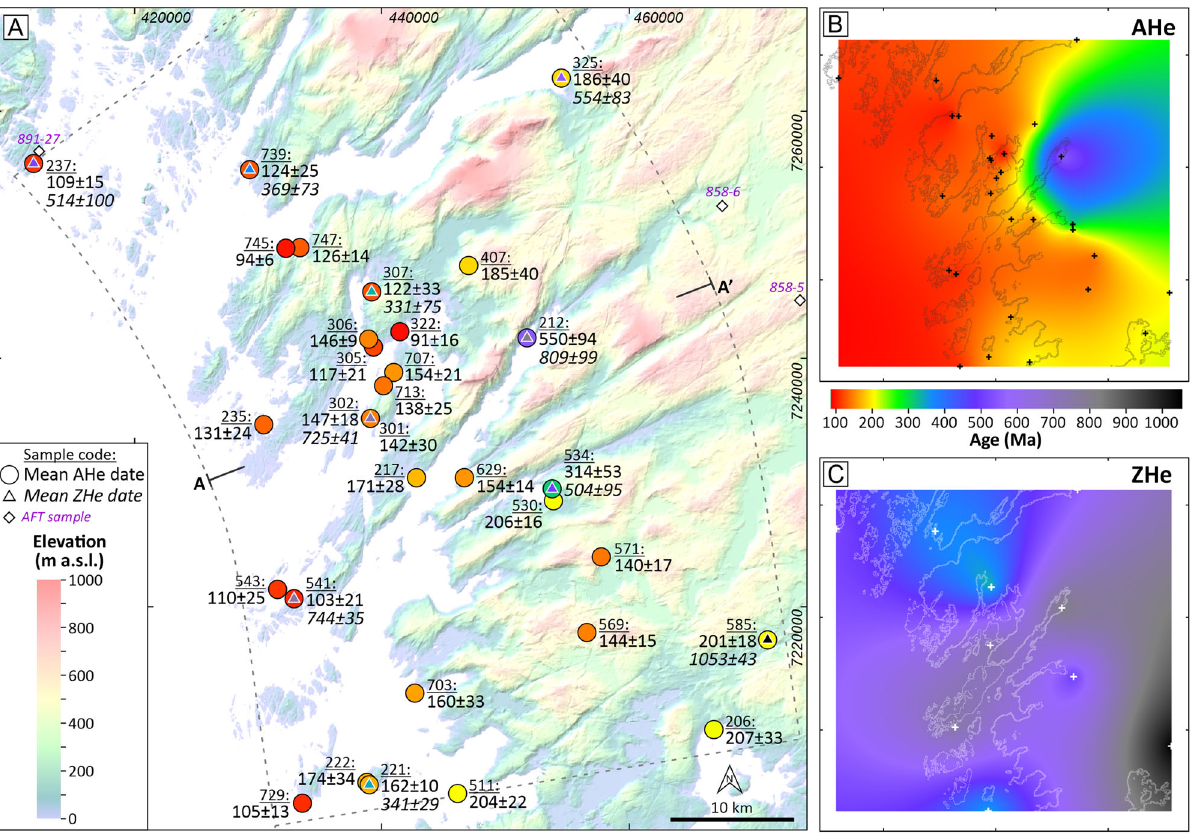
Fig. 2 Summary of (U-Th)/He data. A Digital surface model of Maniitsoq region showing spatial distribution of thermochronology results (i.e., sample codes, mean (U-Th)/He dates (numerical and color-coded) and 2 σ uncertainties (both in Ma)), the locations and sample codes of apatite fi ssion-track (AFT) samples of Green et al. 14, 17 , and the location of swath pro fi le A-A ’ displayed in Fig. 3. B , C Interpolated AHe and ZHe dates heat maps obtained by Kriging method. Sample locations are indicated by black and white dots; age scale is identical with part